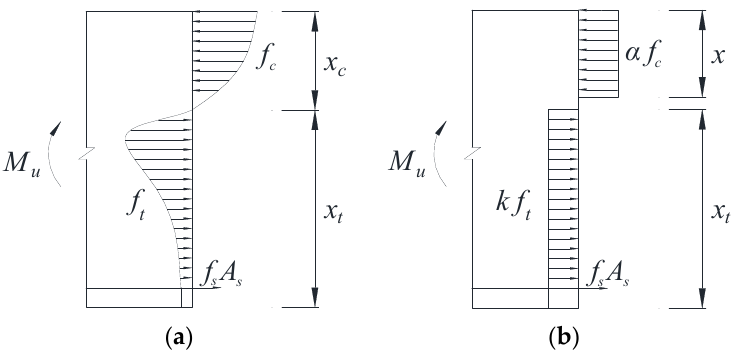
Figure 7. Stress distribution of normal section of properly reinforced beams under failure: ( a ) Actual stress distribution; ( b ) Equivalent stress distribution.